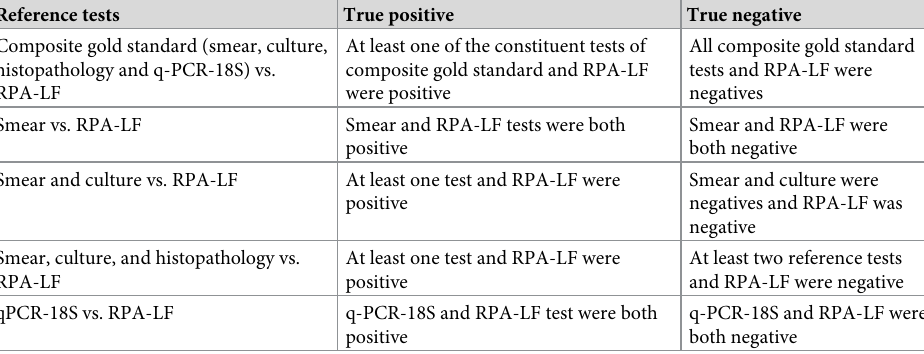
Table 1. Definitions of true positives and negatives according to reference